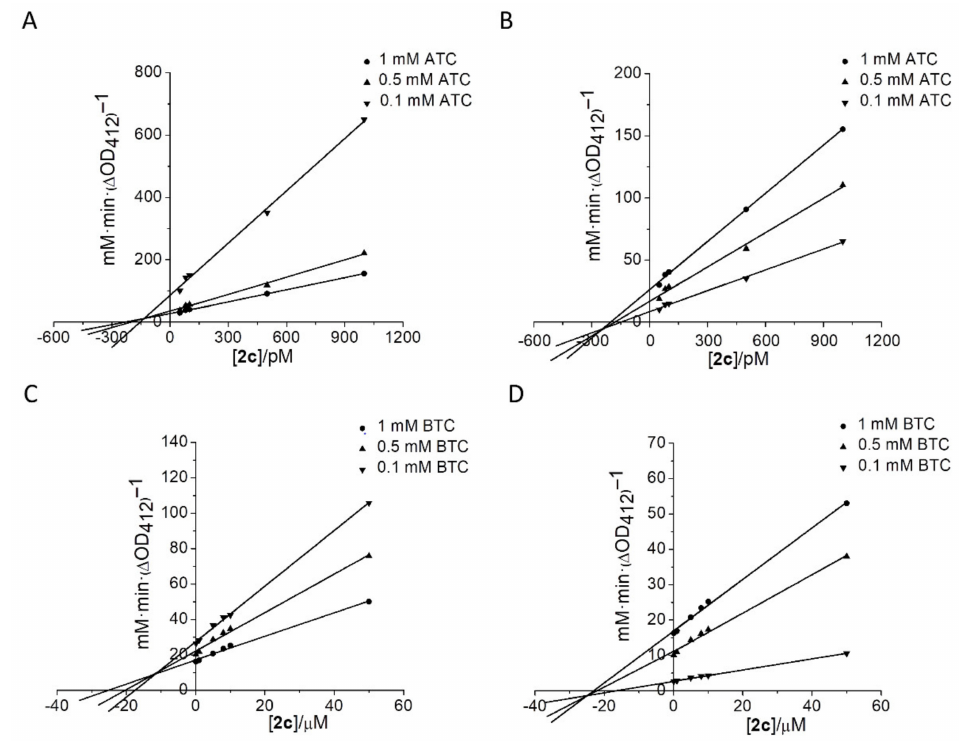
Figure 3. Determination of reversible inhibition type and inhibition constants of hAChE ( A , B ) and hBChE ( C , D ) by compound 2c . ( A,C ) Dixon plot; ( B,D ) Cornish-Bowden